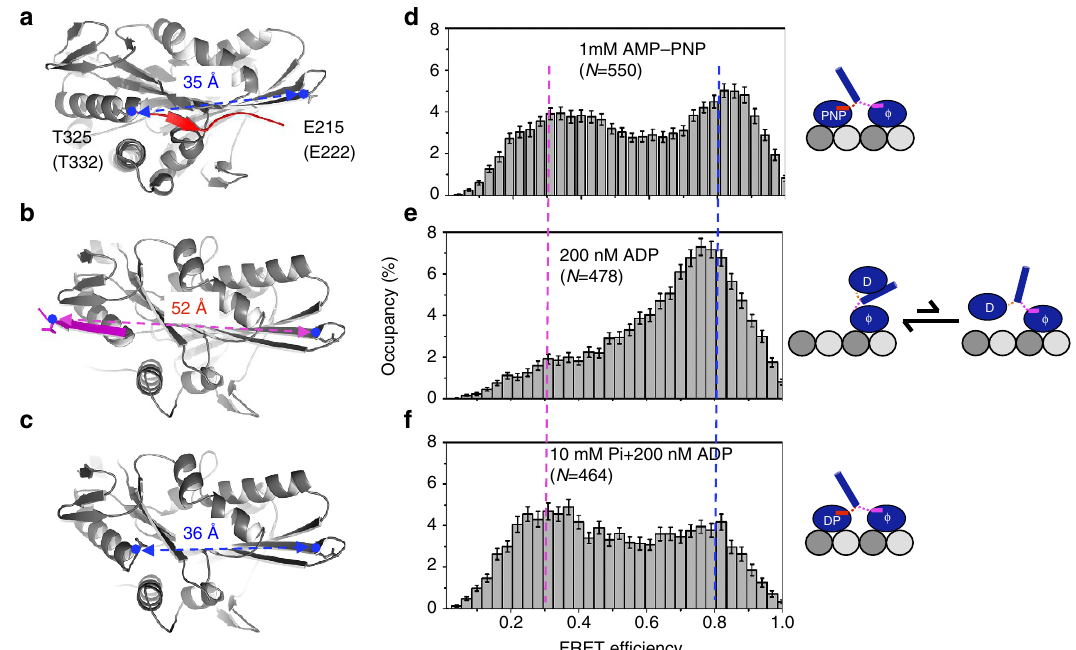
Figure 3 | smFRET analysis of the conformational changes of NIS of kinesin-1 in different nucleotide states. ( a ) Structure of human kinesin-1 in ATP- bound state (PDB code 3J8Y) with the forward-docked NL coloured red. The positions of the residues for dye labelling are shown in blue. The numbers in the parentheses show the equivalent residues of Drosophila kinesin-1. The FRETpair spans a distance of B 3.5nm. ( b ) Proposed structure of kinesin-1 in apo state with a backward-docked NIS (in magenta) as in the structure of Zen4. The FRETpair spans a distance of B 5.2nm. ( c ) Structure of kinesin-1 in ADP- bound state (PDB code 1BG2). The FRET pair spans a distance of B 3.6nm. ( d – f ) Histograms of FRET efficiency of the dye-labelled kinesin bound to microtubule in 1mM AMP–PNP, 200nM ADP and 10mM Pi þ 200nM ADP, respectively. The numbers in parentheses show the molecules analysed. The dotted lines illustrate peaks characteristic of the high FRET (blue) and low FRET (magenta) signals. The cartoon diagrams show the predicted models of kinesin at the corresponding nucleotide conditions. Red and magenta bars illustrate the forward and backward-docked conformations of the NL, respectively. The double arrows in ( e ) illustrate the equilibrium between disordered and backward-docked NL. Error bars indicate s.d. of 1,000 bootstrap samples of the FRET